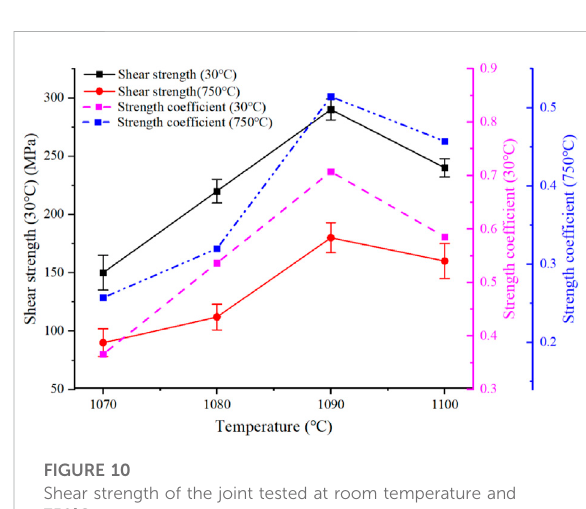
FIGURE 10 Shear strength of the joint tested at room temperature and 750 °